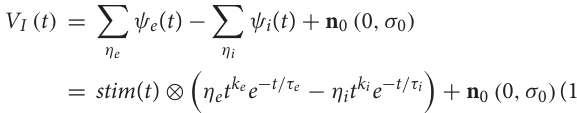
the last line of the table: a function representing the neural metabolic demand evoked by the neural response to the stimulus presentation is convolved with the metabolic response kernel ( mrk